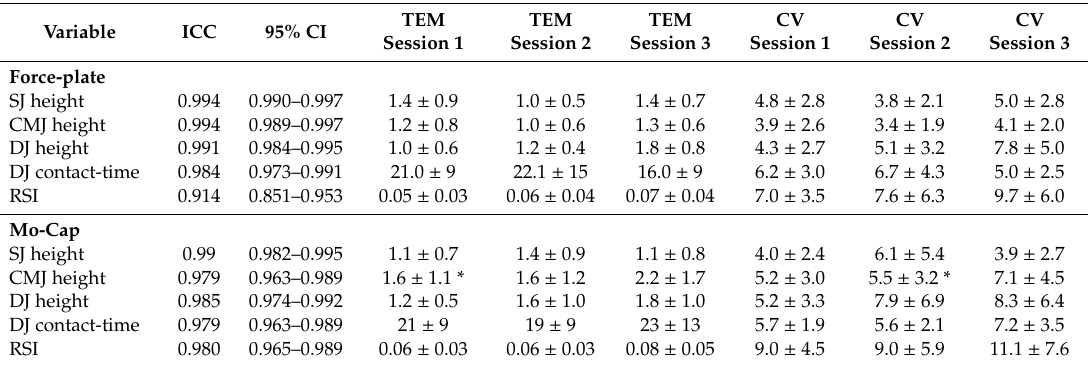
Figure 3. Mean ( ± SD) contact-time and reactive strength index per session recorded by force-plate, Mo-Cap, G-Flight, and PUSH across squat, countermovement, and drop jumps. Arrows denote p < 0.05. Table 2. Intraclass correlation coe ffi cient (ICC), typical error of measurement (TEM), and coe ffi cient of variance (CV) for force-plate, Mo-Cap, G-Flight, and Push for each jump, contact-time, and RSI of three repetitions of each test